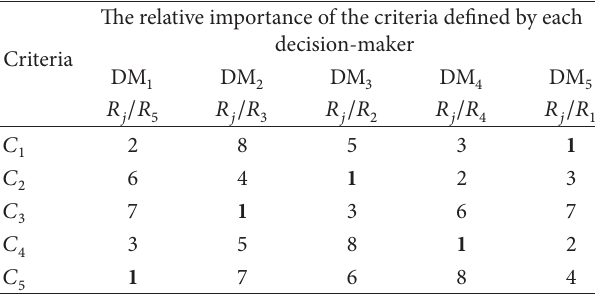
Table 9: The ranks of criteria assigned by each decision maker.